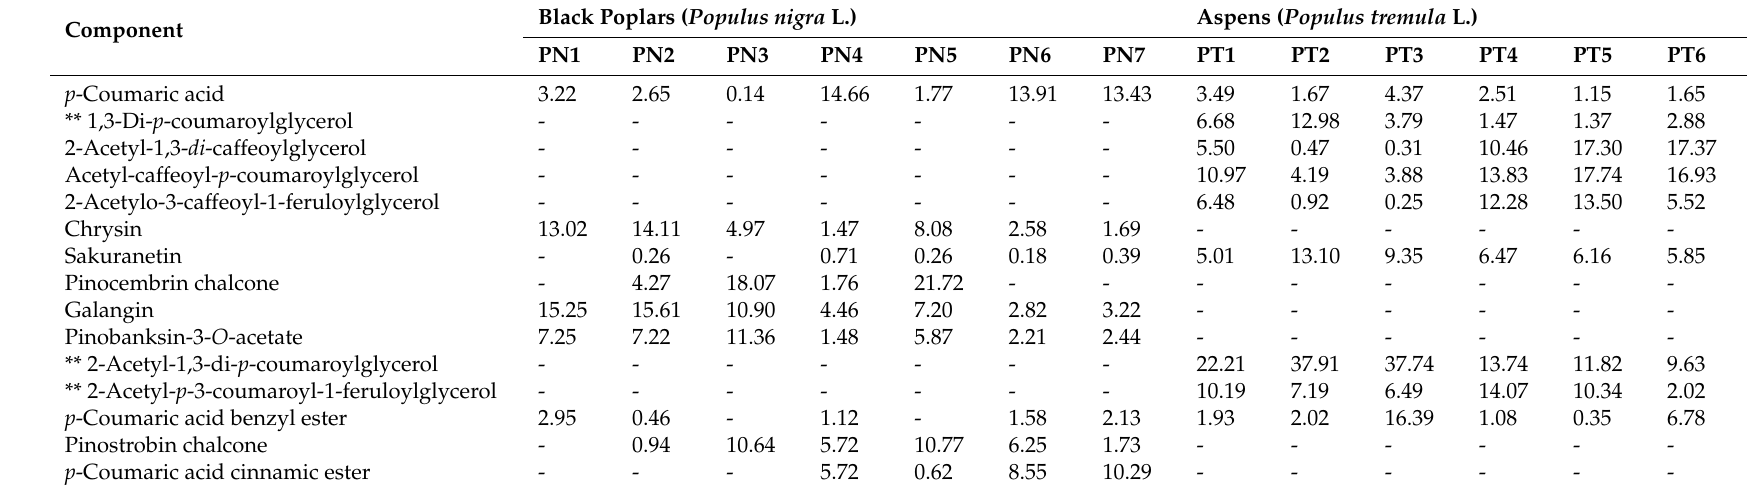
Table 5. Main components of Populus spp. 70% ethanol in water extracts